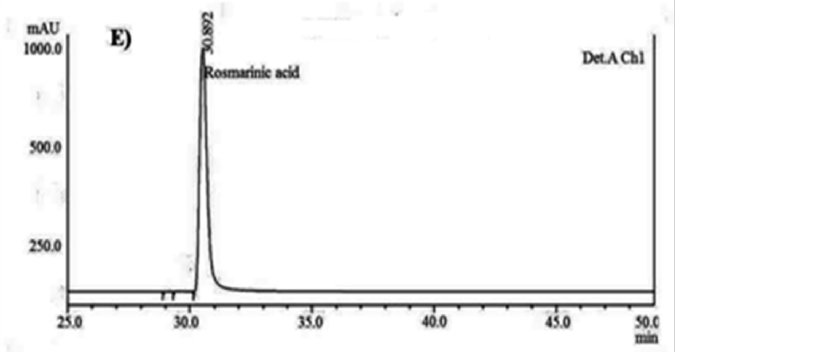
Figure 3. HPLC chromatogram for purity check of individual compounds isolated from the extracts of H. pinifolia. ( A ). p- Anisic acid; ( B ). Caffeic acid; ( C ). p- Coumaric acid; ( D ). Vanillic acid; ( E ).